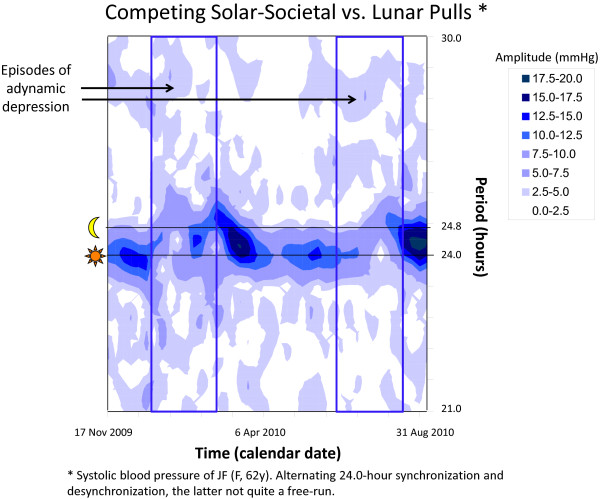
Gliding spectral window (surface chart). Systolic blood pressure was automatically measured around the clock by a 62-year old woman with recurring episodes of adynamic depression occurring twice a year and lasting 2–3 months. Complementary nonlinear analyses (not shown) indicate the coexistence of about 24.0- and 24.8-hour components, their relative prominence alternating between wellness and adynamic depression. Changes in the most prominent circadian period as a function of time are apparent from the changes in amplitude (shading) and location along the vertical scale. © Halberg Chronobiology Center.